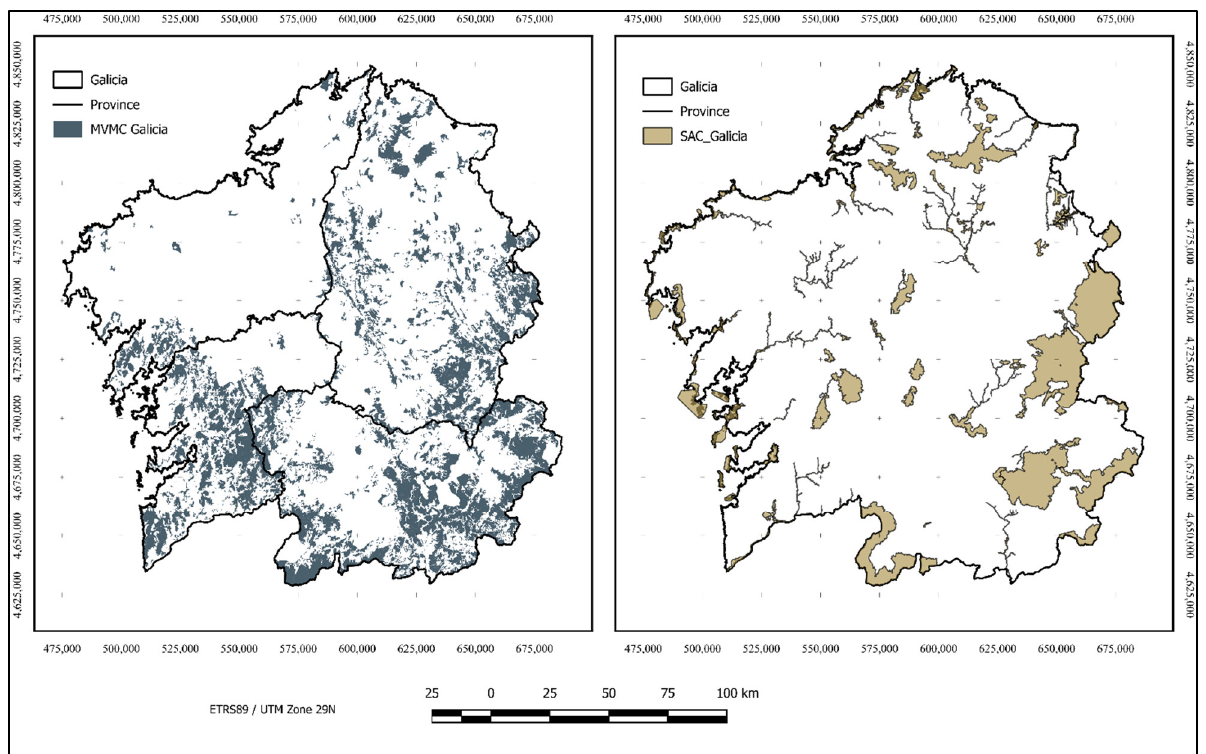
Figure 2. The distribution of the MVMCs and SACs in Galicia.